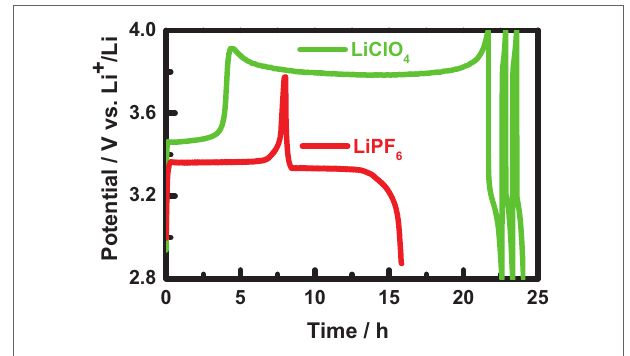
FigUre 4 | The charge and discharge curve of in situ X-ray diffraction coin cells with different electrolytes as 1 M LiClO 4 in a mixture of ethylene carbonate (EC) and diethyl carbonate (1:1 in volume, green) or 1 M LiPF 6 in a mixture of EC and dimethyl carbonate (1:1 in volume, red). Here, the charge–discharge measurements were conducted at a current rate of C/10 within a potential range of 2.8 − 4.0